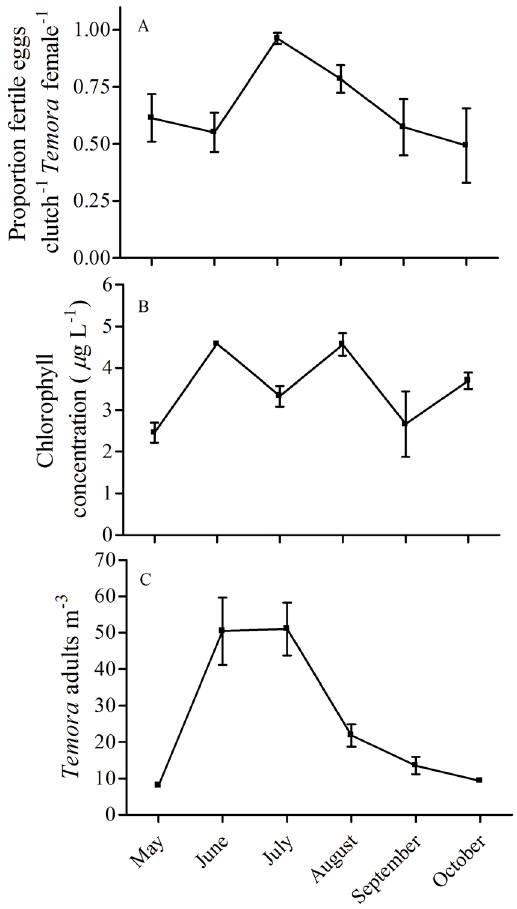
Figure 2. Seasonal dynamics of the (A) fertilization status of Temora longicornis , (B) chlorophyll concentration, and (C) population density from the Damariscotta river estuary in coastal Maine, USA. Zooplankton samples were collected during 5 day field surveys conducted at 3 week intervals from May to October 2008 ( n =30) in coastal